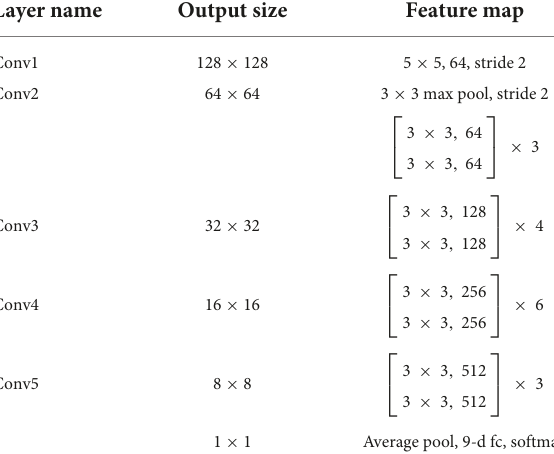
TABLE 3 The architecture of